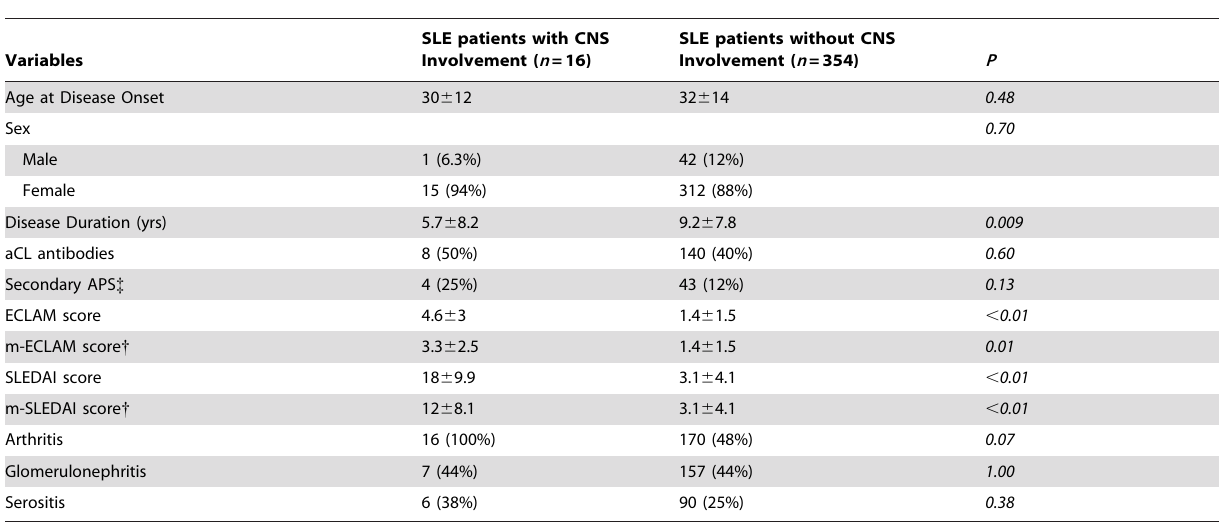
Table 3. Demographic and clinical characteristics of n = 370 SLE patients by CNS involvement